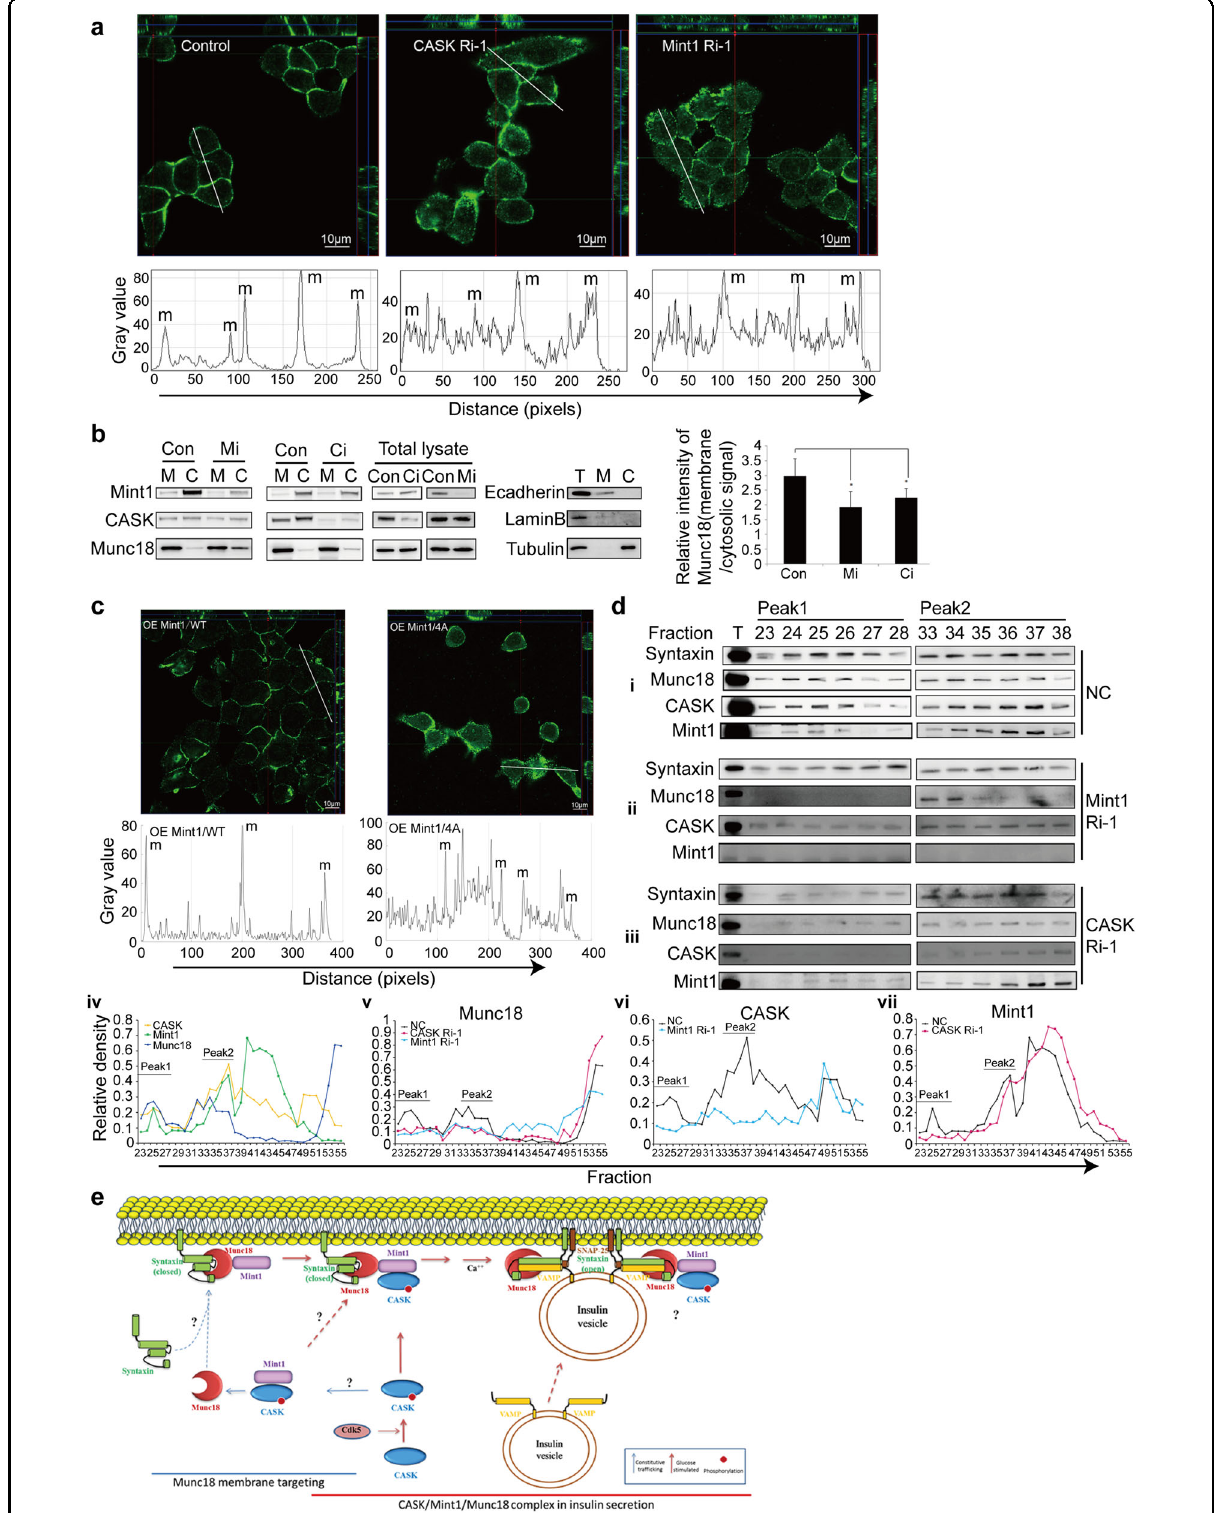
Fig. 7 (See legend on next